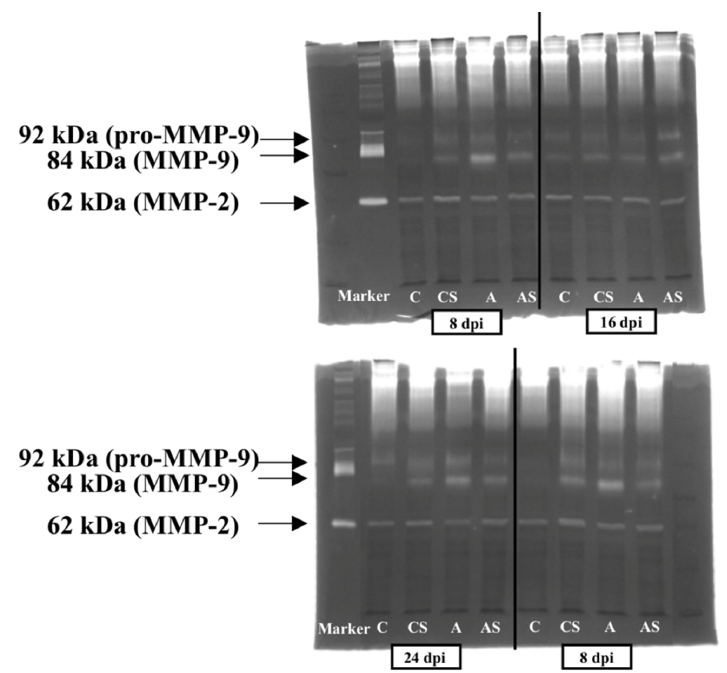
Figure A1. Visualization of gelatin zymography determining the level of matrix metalloproteinase 2 (MMP-2) and 9 (MMP-9) and matrix pro-metalloproteinase (pro-MMP-9) in immunocompetent mice infected with Acanthamoeba spp. A: Immunosuppressed mice infected with Acanthamoeba spp.; AS: Immunocompetent mice uninfected with Acanthamoeba spp.; C: Immunosuppressed mice uninfected with Acanthamoeba spp.; CS: At 8, 16, and 24 days post-infection (dpi).